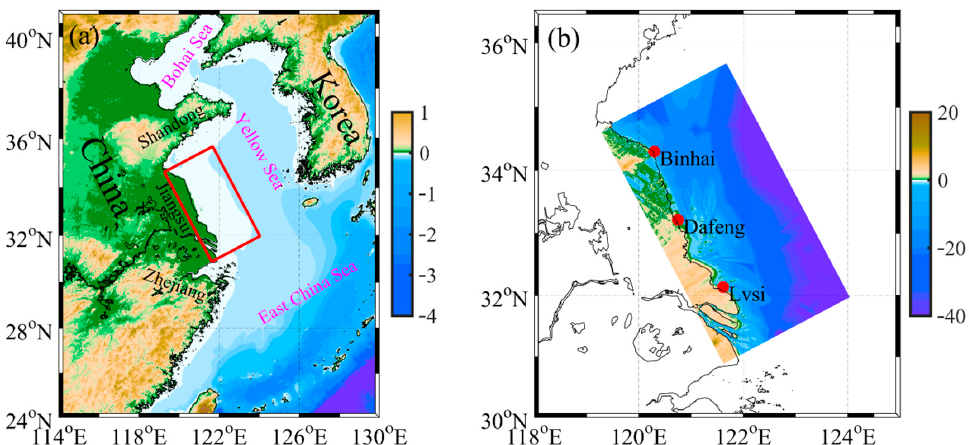
Figure 1. ( a ) Location and topography (km) of the model domain. The topography was downloaded from the ETOPO1 dataset. ( b ) A zoom-in view of the model domain (m). Three tidal gauges, named Binhai, Dafeng, and Lvsi, are denoted by the red dots.